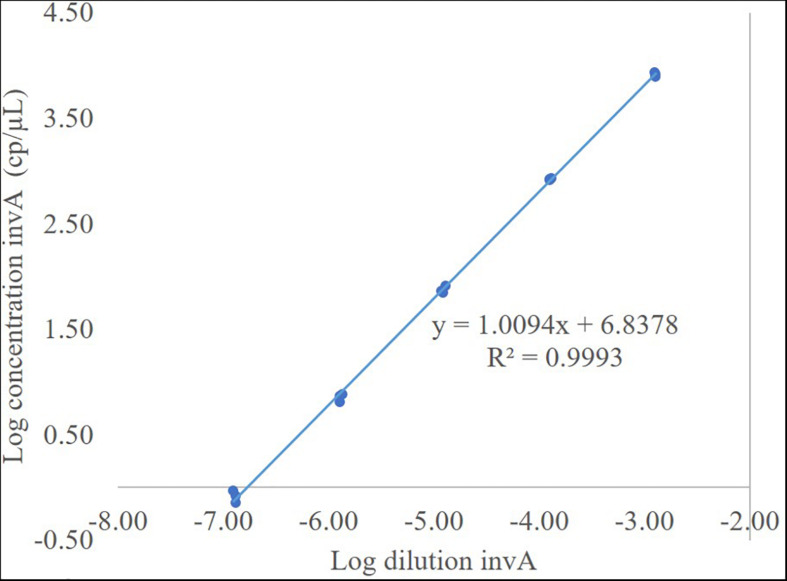
The working interval for invA. Total DNA gravimetric dilution in Log scale vs. DNA concentration (cp/μL) in Log scale.